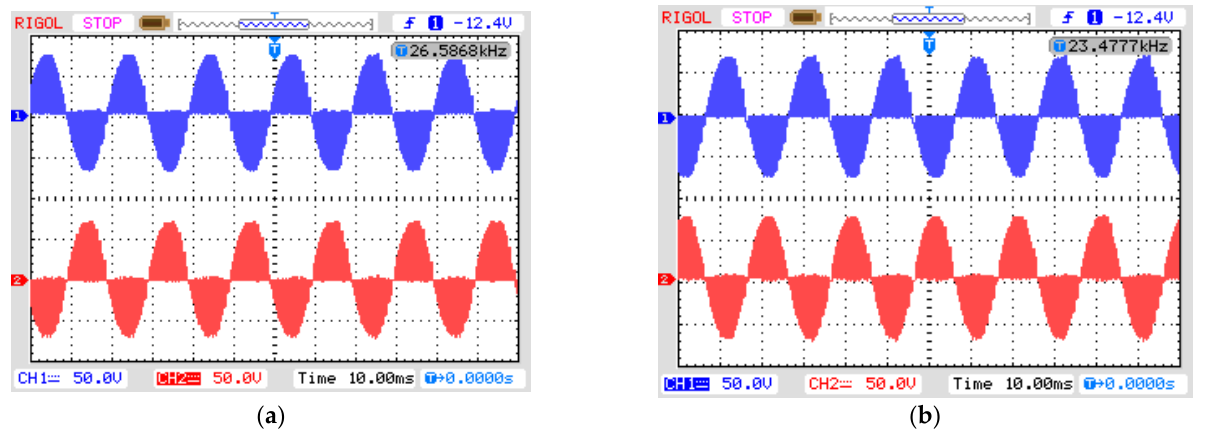
Figure 15. Practically obtained results for output step-down process across T r 1 , D 1 (blue) and T r 3 , D 3 in ( a ) non-inverted form and ( b ) inverted form.